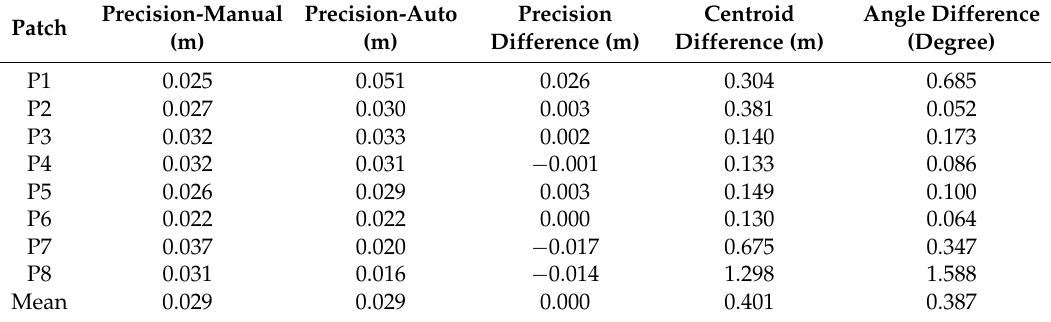
Table 6. Plane fitting precision, plane fitting precision difference, centroid difference, and angle difference values for building #1 (Adaptive cylindrical